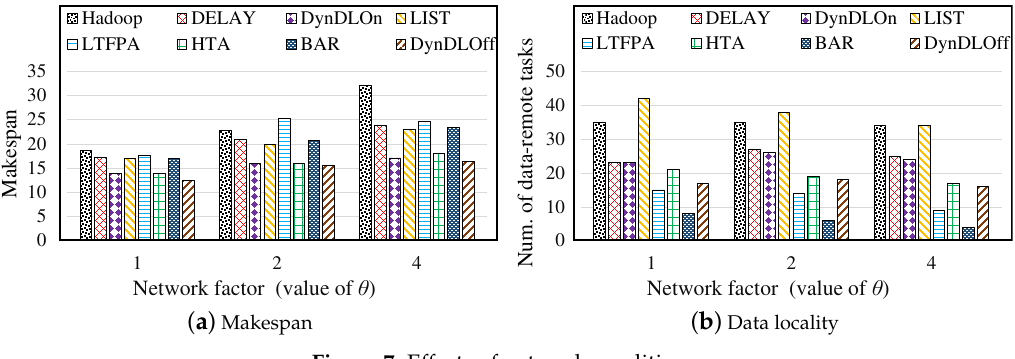
Figure 7. Effects of network